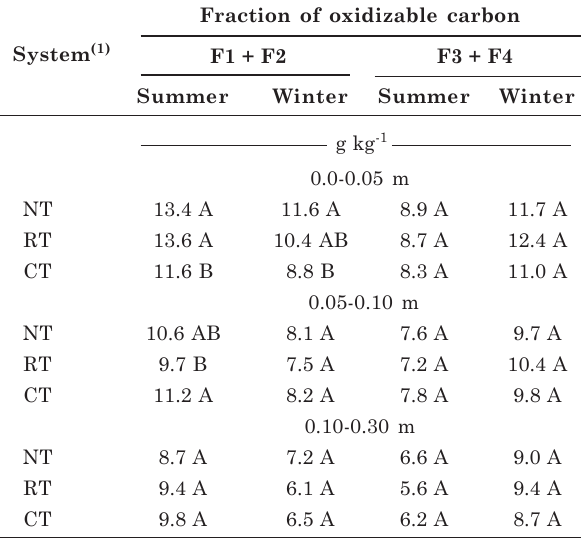
Table 4. Fractions of oxidizable carbon in soil of different tillage systems, soil layers and sampling